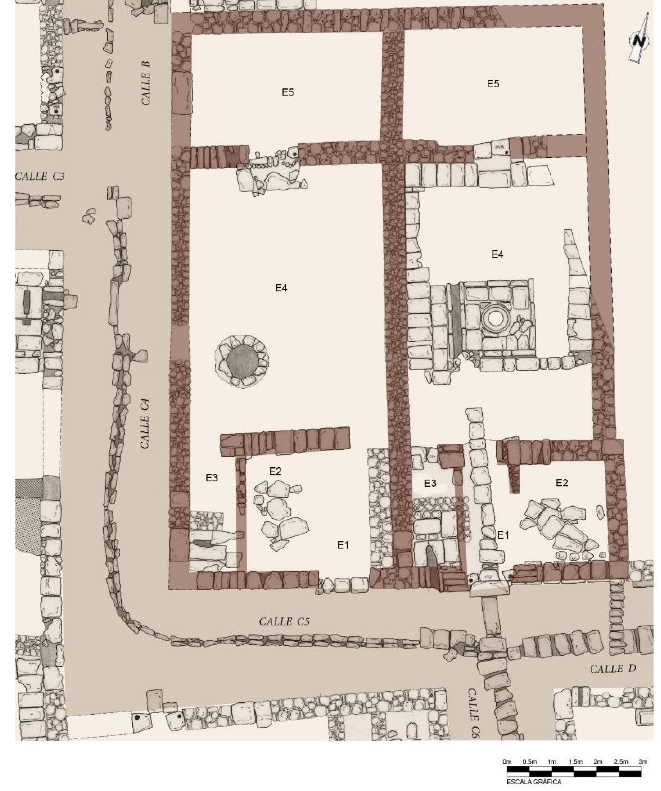
Figure 7. Variant 1. Houses 37—left and 38. Plan and room distribution.